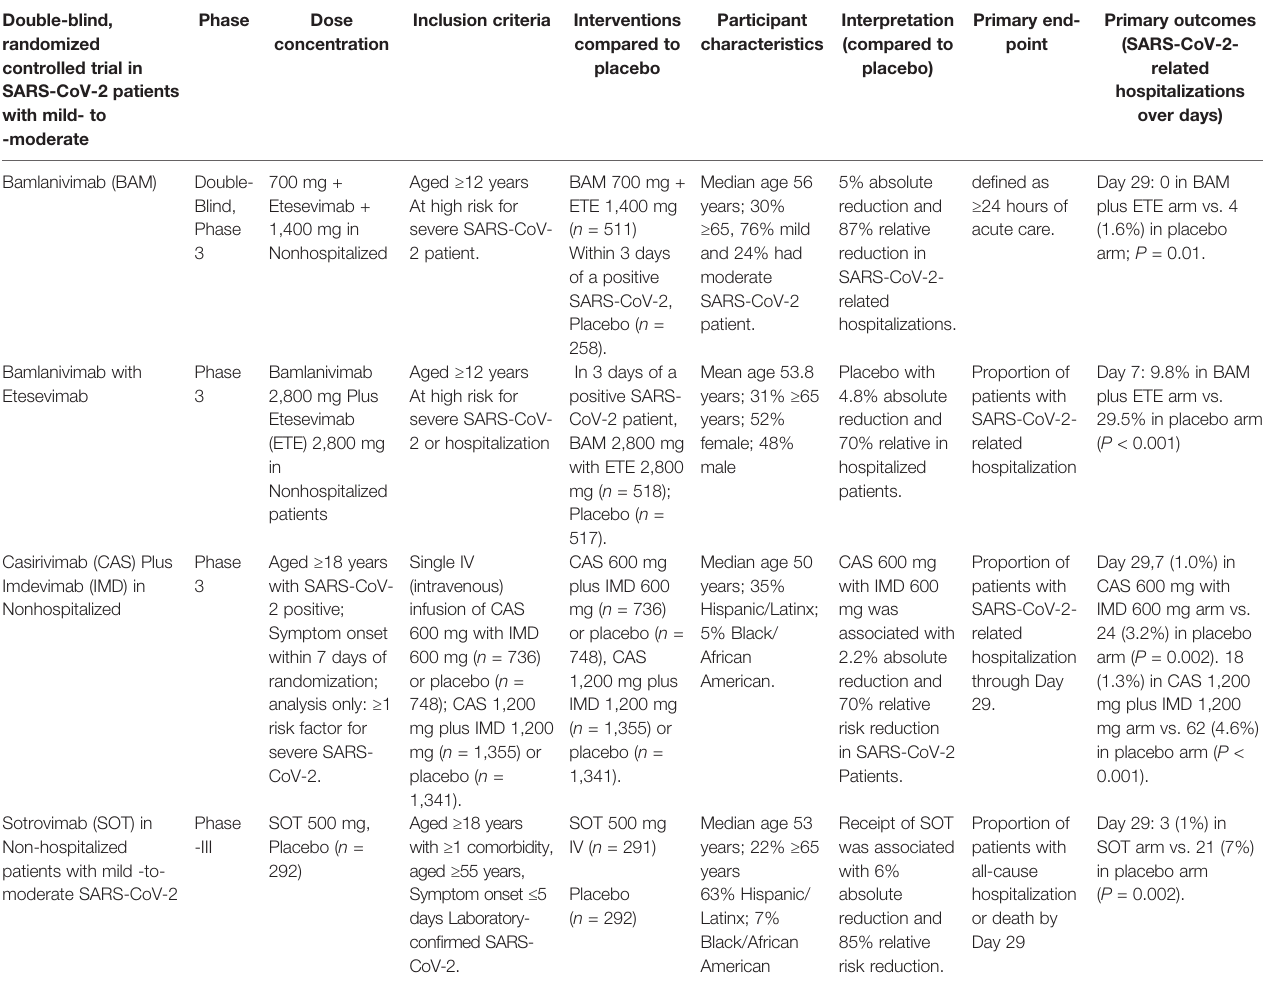
TABLE 4 | Recent updates on clinical data of anti-SARS-CoV-2 selected monoclonal